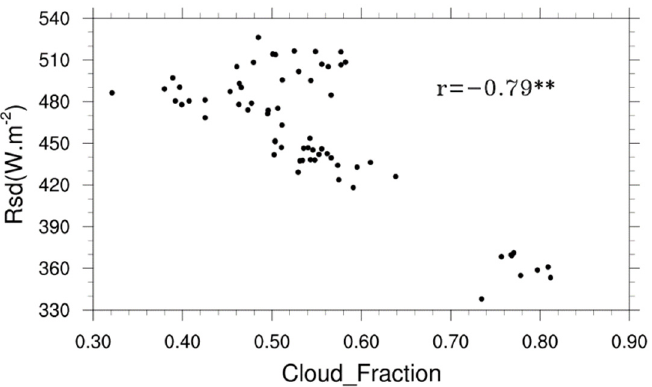
Figure 4. Relationship between the monthly average of downward shortwave radiation and the monthly average of cloud fraction. ** Significantly correlated at the 0.01 level (bilaterally).